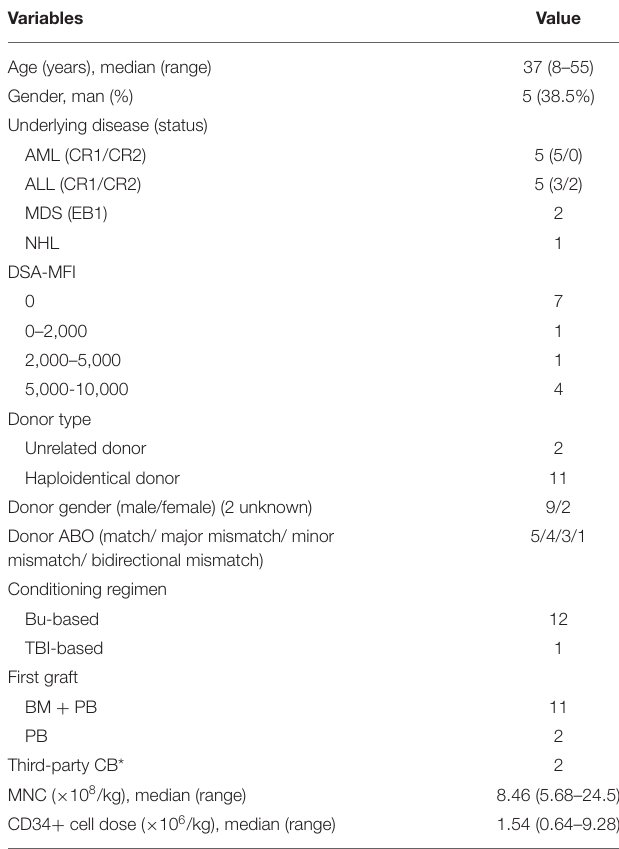
TABLE 1 | Patient characteristics at first